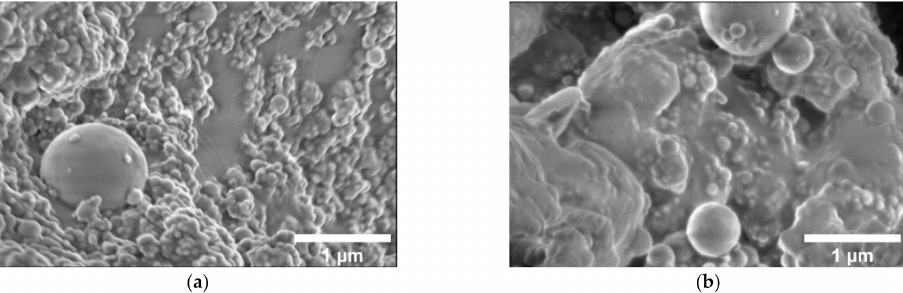
Figure 2. Scanning electron microscopy micrographs of mono-filled Ni@C/epoxy resin composites with ( a ) 10 and ( b ) 25 vol.% of